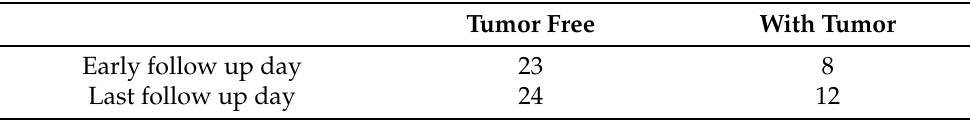
Table 4. Number of patients in the validation data.